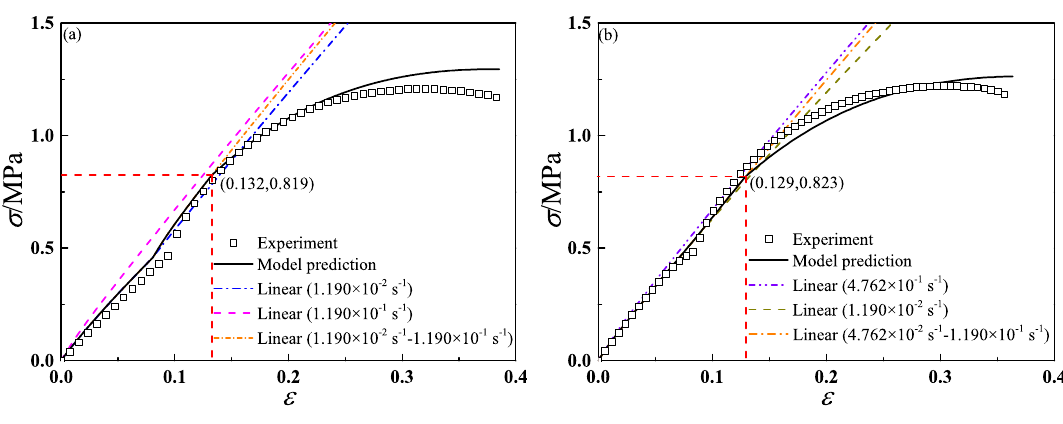
Figure 17. The validation results of tensile dual strain rates